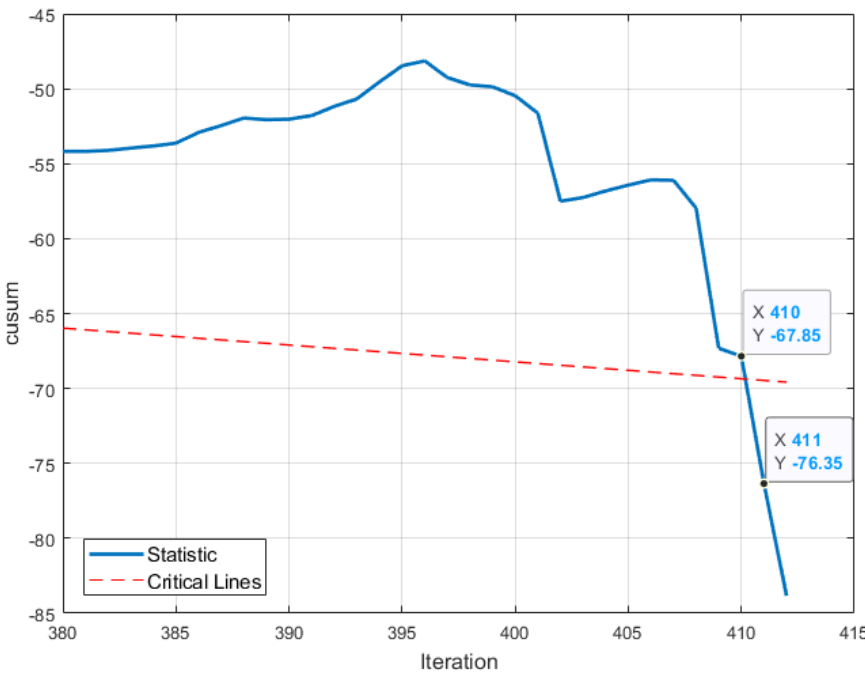
Figure 9. Zoomed data from Figure 8 displaying the detection process of F1.